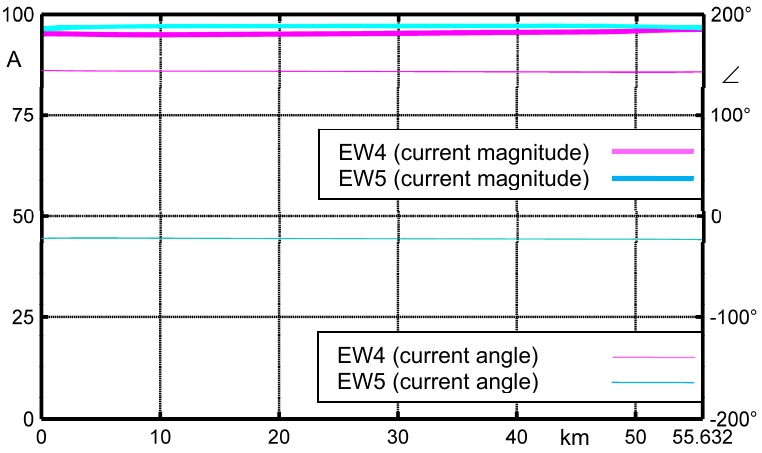
Figure 9. Earth wire current magnitudes (left axis) and angles (right axis) along the